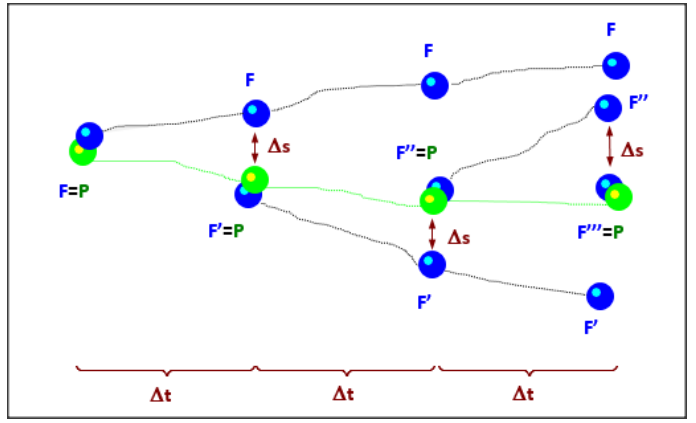
Figure 2. Construction principle of an inertial particle trajectory in the random walk model (RWM).